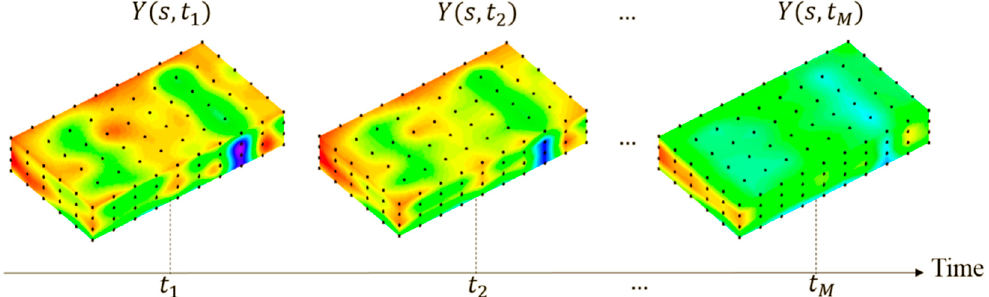
Figure 3. Time-varying grain temperature field.